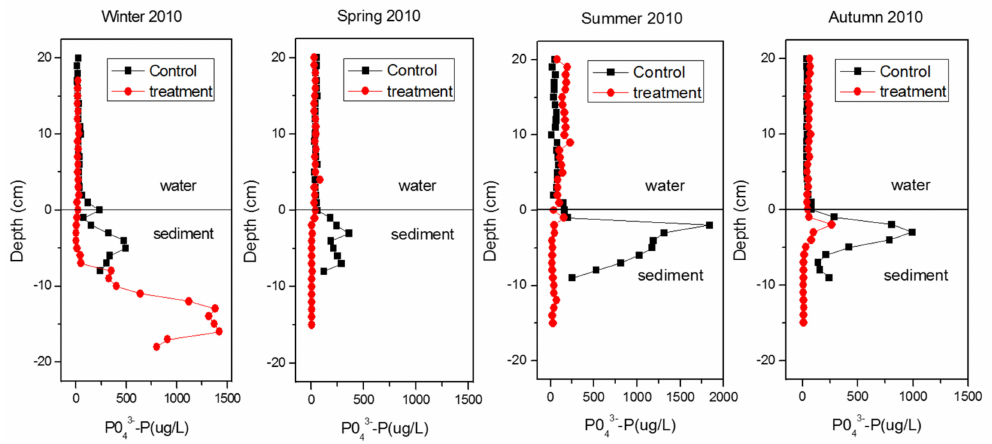
− − P profile throughout the year at the treated sediment area ( red ) and 4